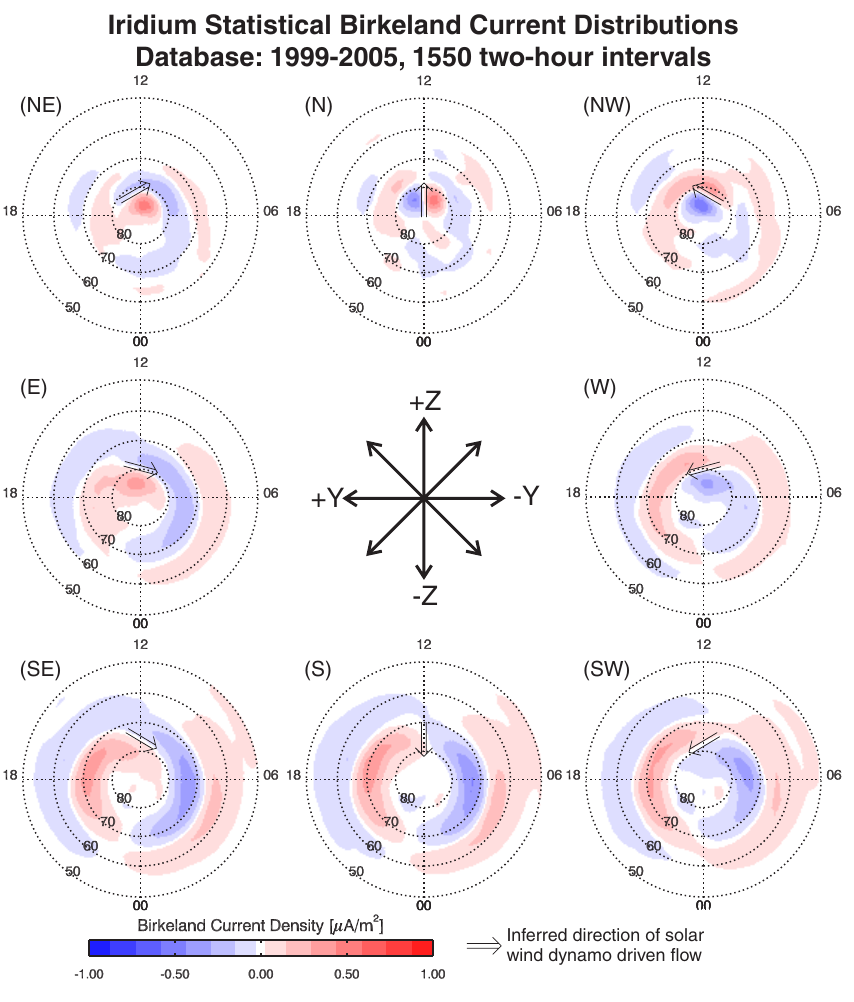
Fig. 5. Statistical distributions of the large-scale Birkeland currents obtained from analysis of 1550 two-hour global distributions observed by Iridium. The IMF direction projected in the Y - Z GSM plane for each distribution is indicated by the arrows in the center and by the panel labels corresponding to the IMF direction at the subsolar magnetopause. The 2 σ uncertainty levels are given in the lower right corner of each panel. Double line arrows show the inferred direction of flow implied by the most poleward currents. 32